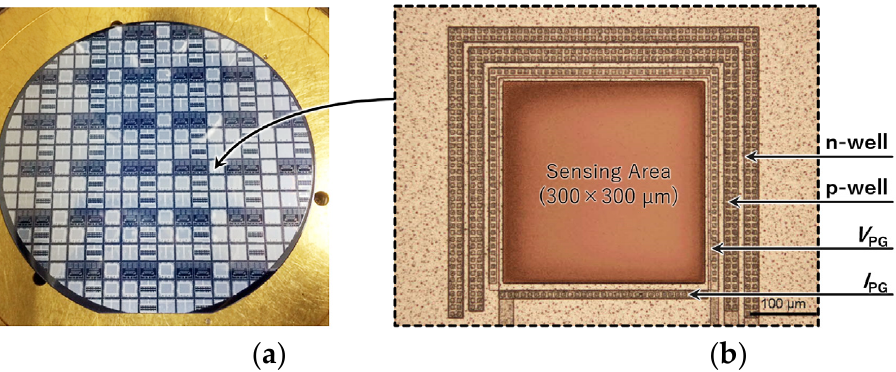
Figure 5. Fabricated filter-free wavelength sensor. ( a ) A picture of the 4-in wafer before the chip dicing process; ( b ) microscope image of the sensing area. Table 1. Ion implantation conditions.